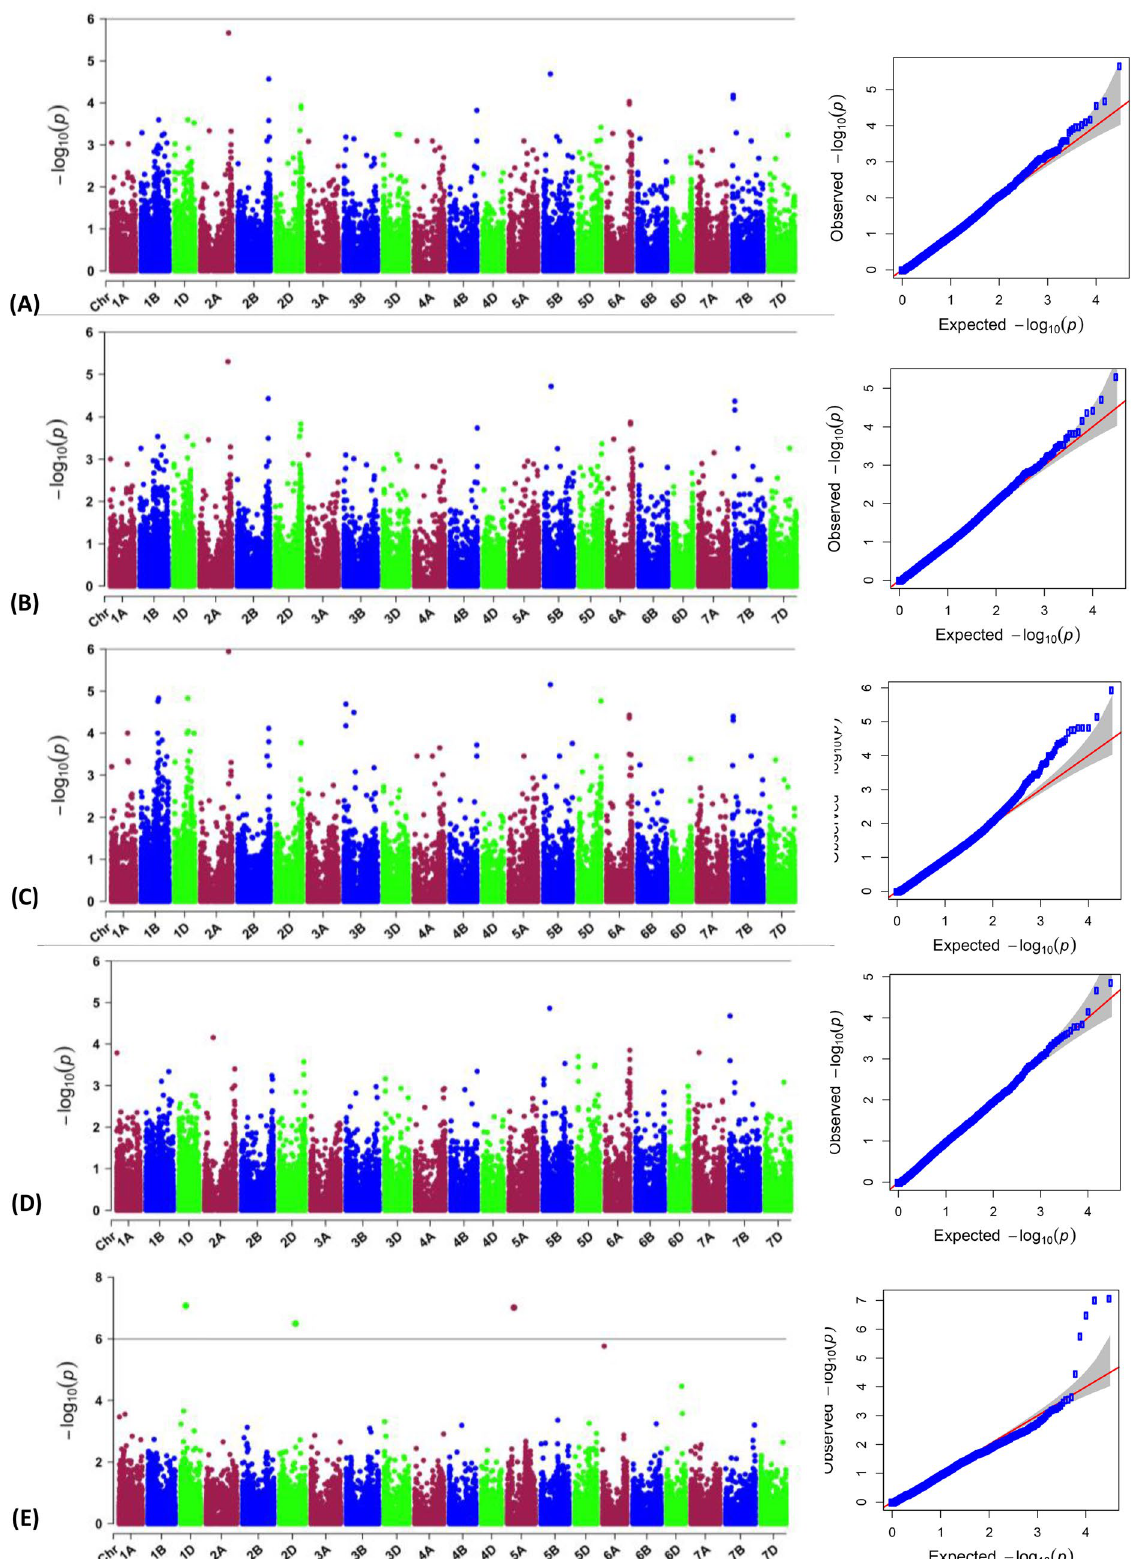
Figure 6. Manhattan plots showing SNP markers associated with different traits and Quantile–Quantile plots for 82 bread wheat accessions grown in hydroponics. (A ) Shoot dry weight, ( B ) Total biomass, and ( C ) Total P uptake, at sufficient phosphorus level, and ( D ) Total biomass, ( E ) P concentration, at low P level. The horizontal green line represents FDR adjusted p < 0.001. The threshold of −log 10 ( P -value) ≥ 6.0 was used as a cutoff to identify association